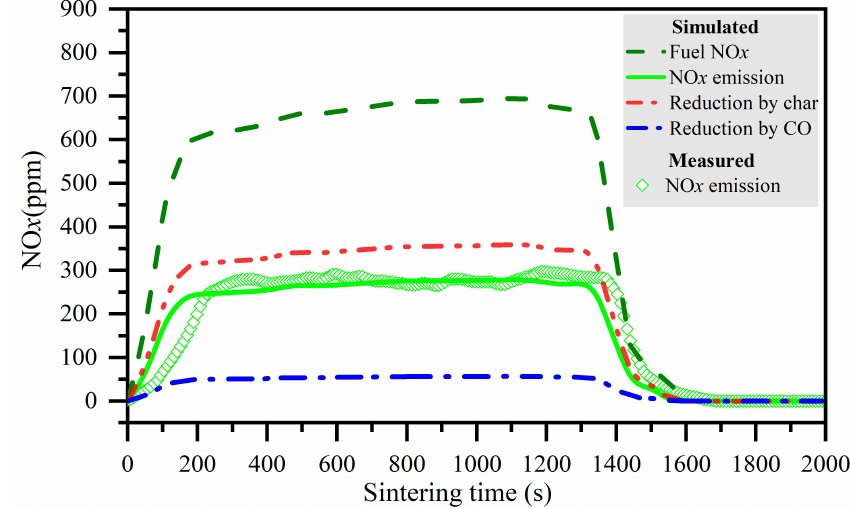
Figure 5. Comparison of NOx simulated and measured results.